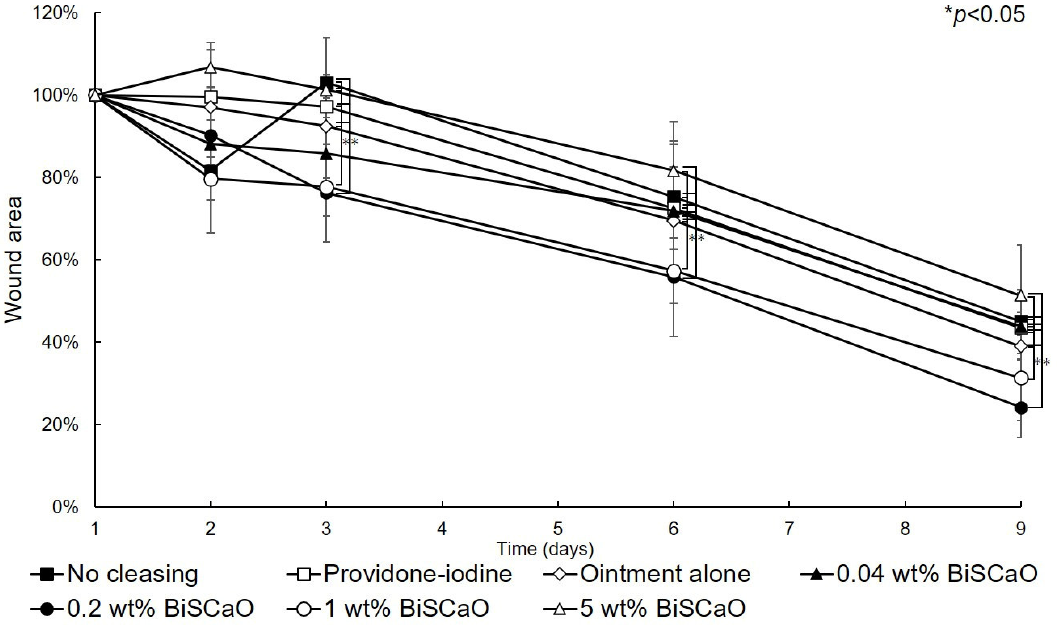
Figure 4. Rate of healing of open wounds. The area of the open wounds on Day 1 was defined as 100%, and the relative open wound area of each group was calculated using the digital photographs in Figure 3. Data are presented as mean ± SD ( n = 6). * p < 0.05; Tukey’s t –test.